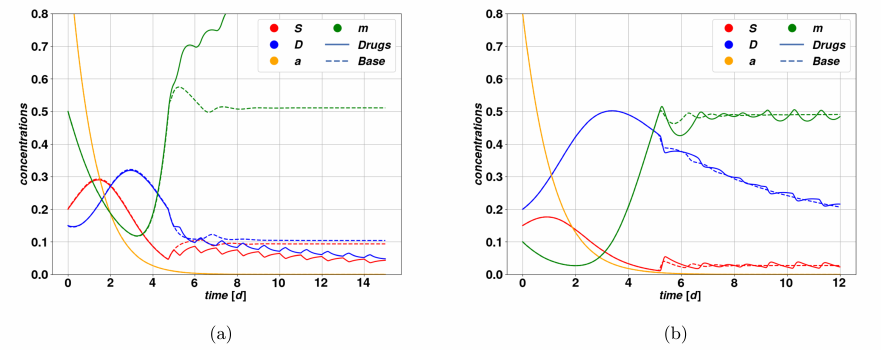
Figure 7. Trajectories of the system variables using a drug that inhibits the plasticity of the differenti- ated cells by reducing the plasticity factor q 0 that regulates the de-differentiation rate (solid lines). The trajectories corresponding to the untreated case are provided for comparison (dashed lines). We keep the same codes of colors as previously for S , D , a and m . ( a ) represents a case of effective treatment, in which the therapy is able to break the feedback loop associated with the plasticity mechanism, and lead the tumor to regression. In ( b ) the trajectories depict a case where treatment on the plasticity factor is not strong enough to lead to a regime change of the tumor going from a self-sustained and stable evolution to progressive annihilation as in ( a ). The relevant parameter values can be found in Tables